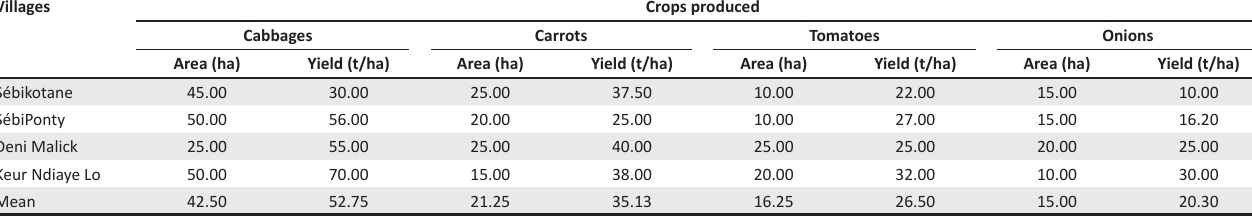
TABLE 1: Agricultural areas and yields from vegetable crops production in the four villages. Villages Crops produced Cabbages Carrots Tomatoes Onions Area (ha) Yield (t/ha) Area (ha) Yield